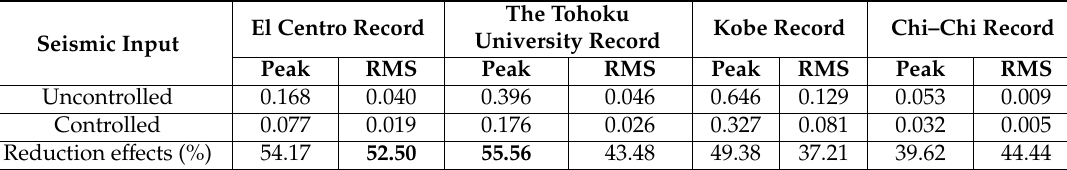
Table 3. Displacement responses at the roof of the test frame (m).